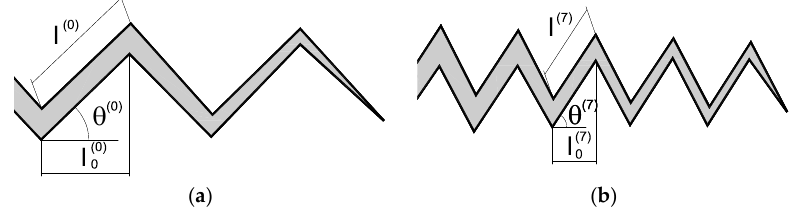
Figure 4. Fatigue crack paths in both materials: ( a ) scheme of the fatigue crack for hot rolled bar; ( b ) scheme of the fatigue crack for cold drawn wire.